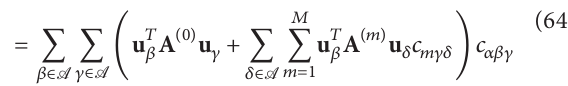
Algorithm 3 now formulates the method of spectral